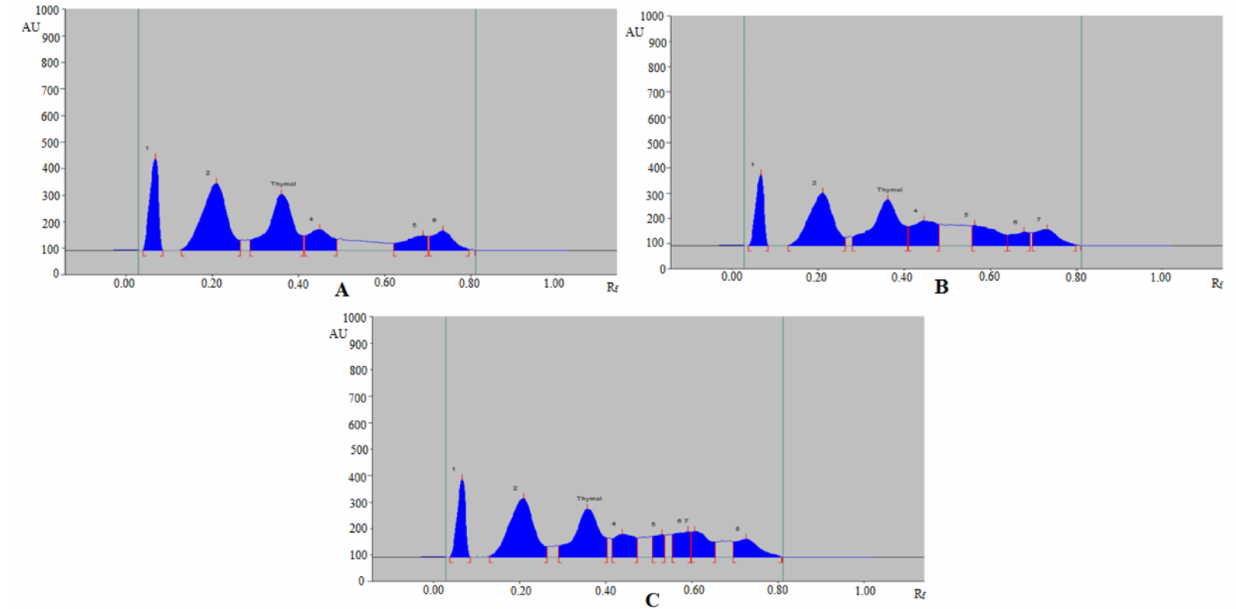
Figure 4. Representative HPTLC chromatograms of thymol in TE of ( A ) T. vulgaris (SA), ( B ) T. vulgaris (IND), and ( C ) T. vulgaris (UK).